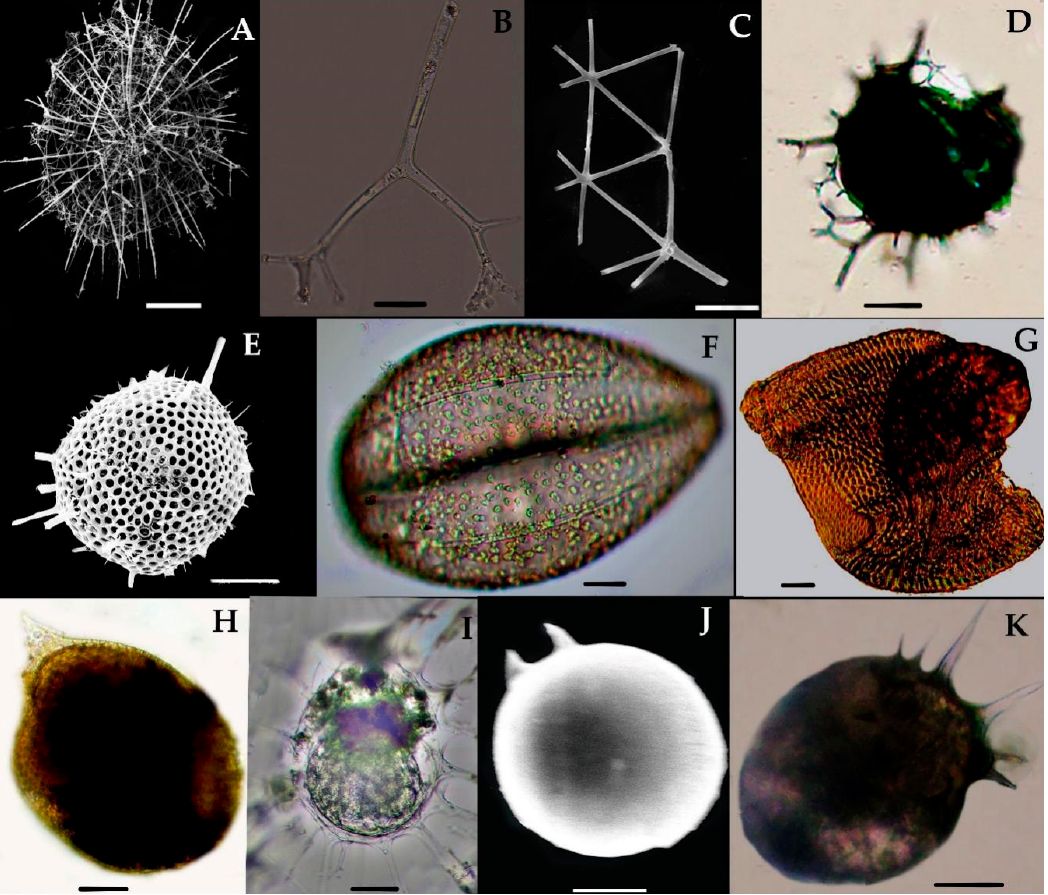
Figure 11. Photomicrographs of Phaeodaria species ( A – K ) of Eastern Indian Ocean. The images were modified from Munir et al. [27] ( A ) Aulacantha scolymantha; ( B ) Auloceras arborescens subelegens ; ( C ) Aulatractus ternaria ; ( D ) Coelodendrum ramosissimum ; E ) Castanidium longispiniim; ( F ) Conchidium compressa; ( G ) Conchidium capsula; ( H ) Conchidium caudatum; ( I ) Pheodarian sp; ( J) Challengeron radians; ( k ) Pharyngella gastrula. Scale bar: 10 µm, 100 µm.